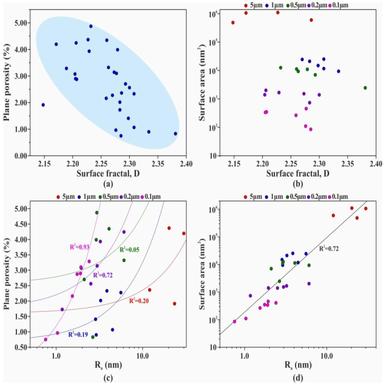
Relationship between matrix surface and pore structure.